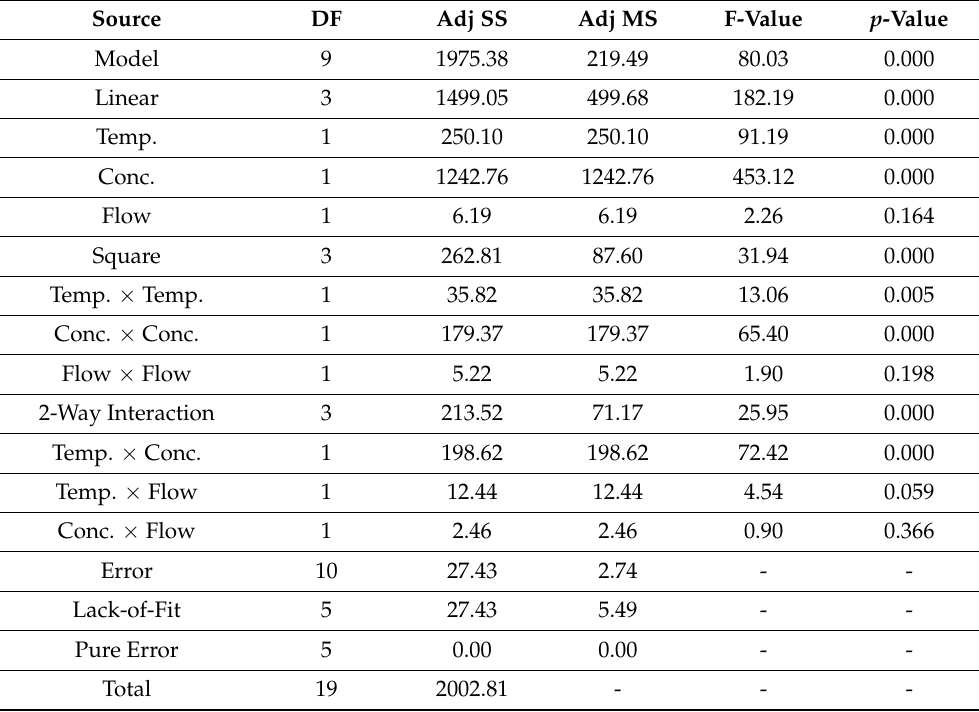
Table 6. Analysis of variance for separation